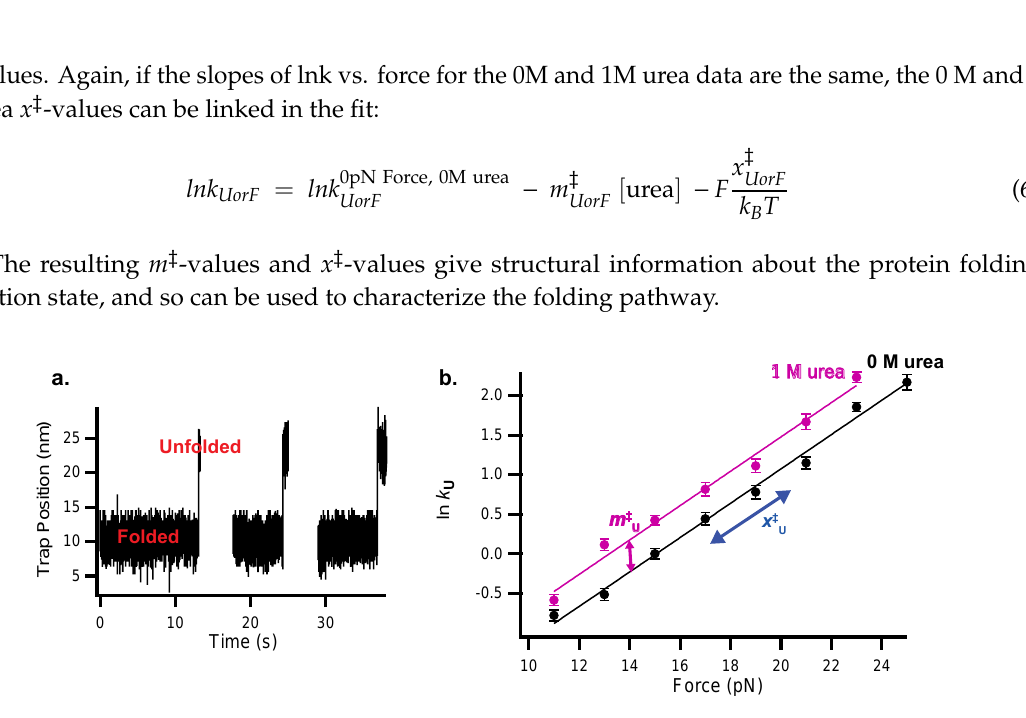
Figure 4. Chemo-mechanical unfolding to explore protein folding kinetics of the src SH3 domain (as studied in reference [13], which is described in the applications section below). ( a ) Example of force-jump data to monitor src SH3 unfolding kinetics where the protein is jumped to a constant force and observed to unfold by monitoring trap position. ( b ) Chemo-mechanical unfolding data showing ln k U as a function of the force in 0 and 1 M urea. The x ‡ U -value is determined from the slope of ln k U vs. force and the m ‡ U -value is determined from the slope of ln k U vs. [urea], or the di ff erence between the 0 M urea and 1 M urea data shown here.